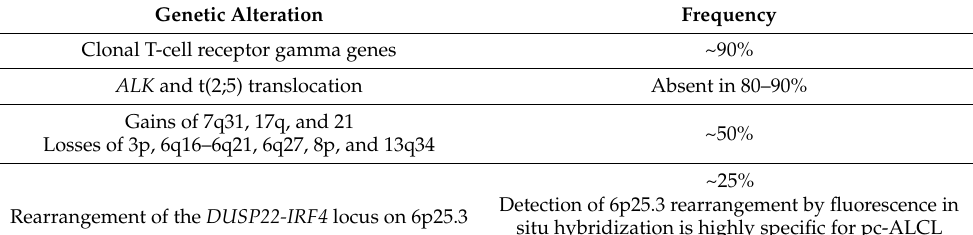
Table 4. Genetic abnormalities in pc-ALCL. Genetic Alteration Frequency Clonal T-cell receptor gamma